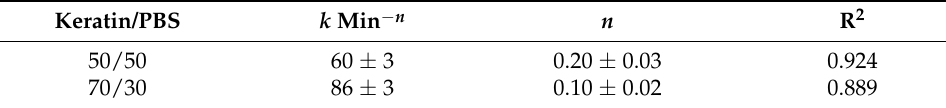
Table 4. Kinetic parameters of Korsemeyer-Peppas model.